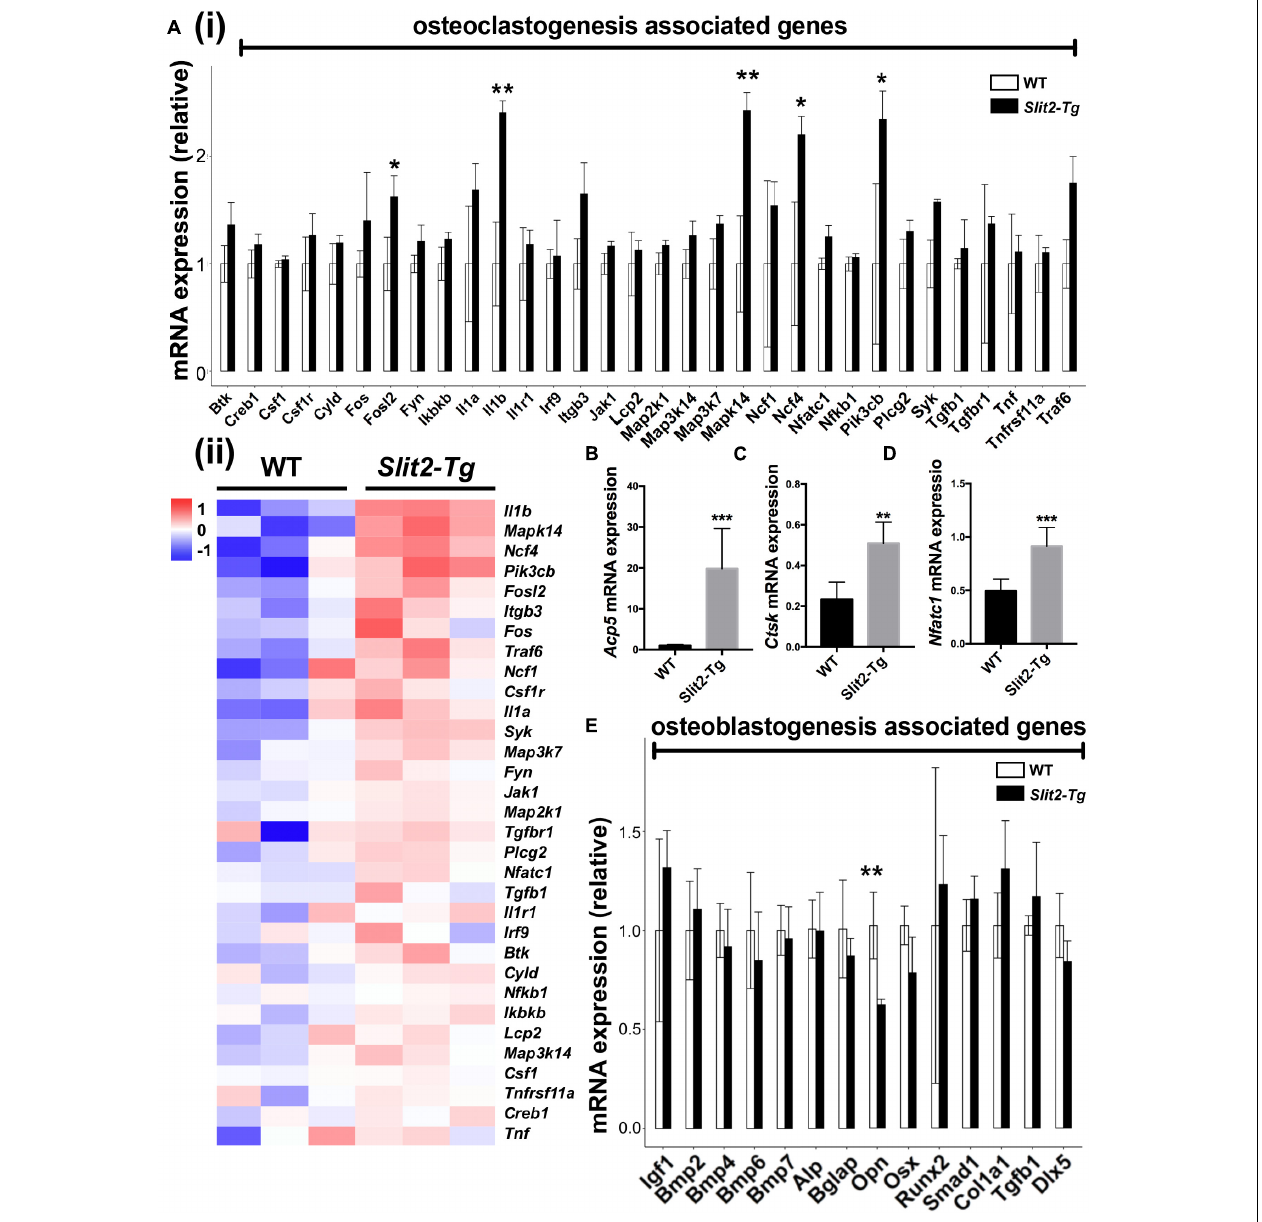
FIGURE 4 | SLIT2 overexpression activates osteoclastogenesis-related signaling pathways in periodontitis. (A (i)) Relative mRNA expression, and (A (ii)) Heat map showing the differential expression pattern of osteoclastogenesis related genes analyzed by RNA-seq ( n = 3). Relative mRNA expression of (B) Acp5 , (C) Ctsk , and (D) Nfatc1 in periodontal tissue analyzed by RT-qPCR ( n = 6). (E) Relative mRNA expression of osteoblastogenesis related genes analyzed by RNA sequencing ( n = 3). Data are presented as mean ± SD. The significant difference among the groups, * P < 0.05, ** P < 0.01, *** P < 0.001. WT: